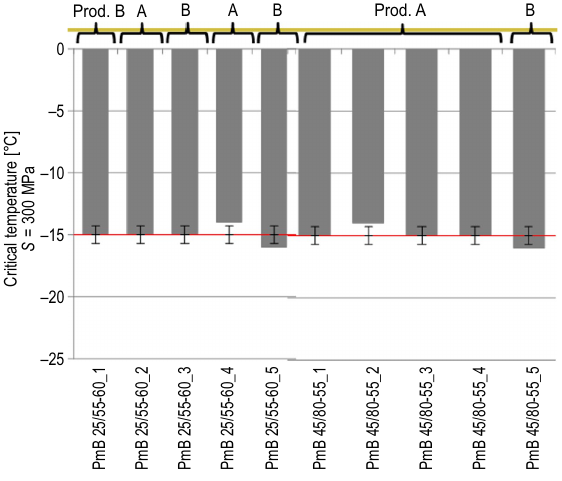
Fig. 11. Polymer modified bitumen critical temperature according to BBR ( S = 300 MPa)